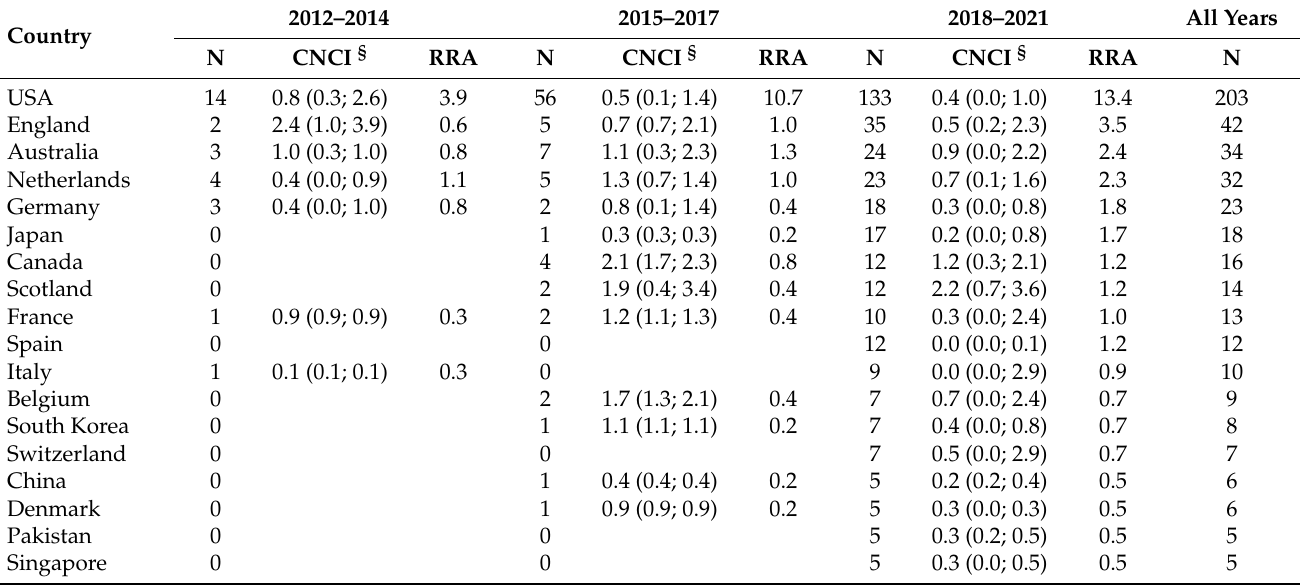
Figure 3. Collaborations between countries among articles on post-intensive care syndrome. Co- authorship-based network. Lines between countries indicate direct links (i.e., co-authorships). Thicker lines are indicative of stronger links (i.e., more co-authorships). The further two countries are apart, the weaker is their relation. Colors indicate the average publication year of a country’s articles. A number of 26 countries with at least three publications were identified. Greece, Portugal, and South Korea were excluded as they did not have any connection to the network. Created using VOSviewer. Table 2. Research output, Category Normalized Citation Index, and relative research activity, by country and time